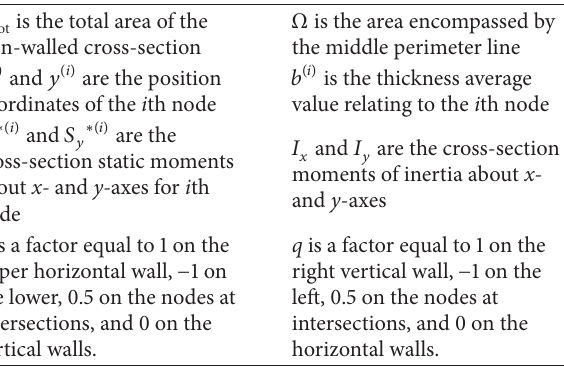
Table 1: Nomenclature for the [𝑆 1 ]